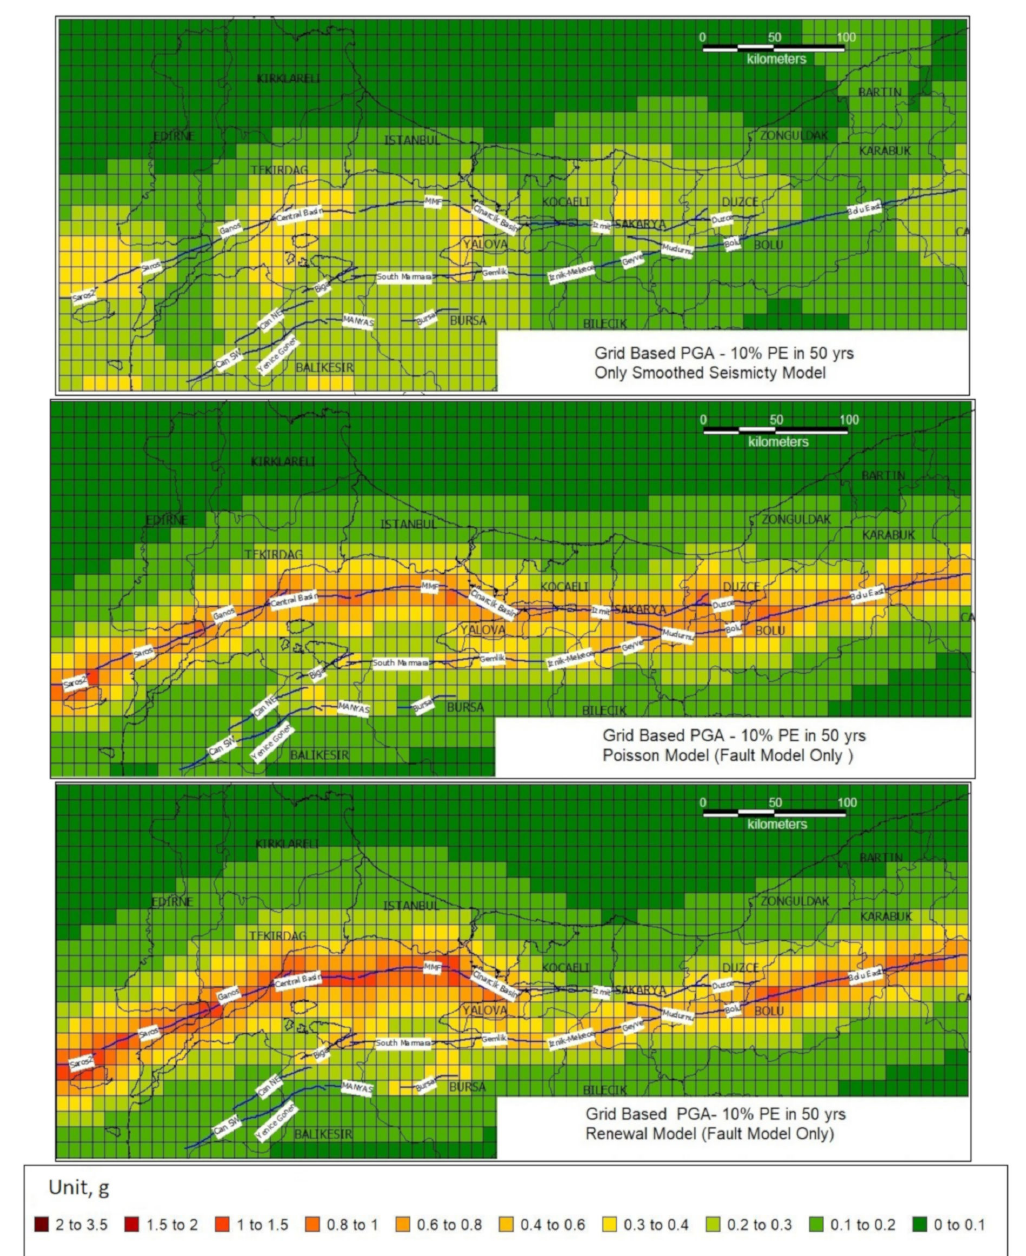
Figure 14. Probabilistic seismic hazard maps in terms of PGA (g) for rock site condition with 10% probability of exceedance in 50 years, derived from the seismicity-based source model (upper panel); fault-based source model with time-independent ERF (central panel) and the fault-based source model with time-dependent ERF (lower